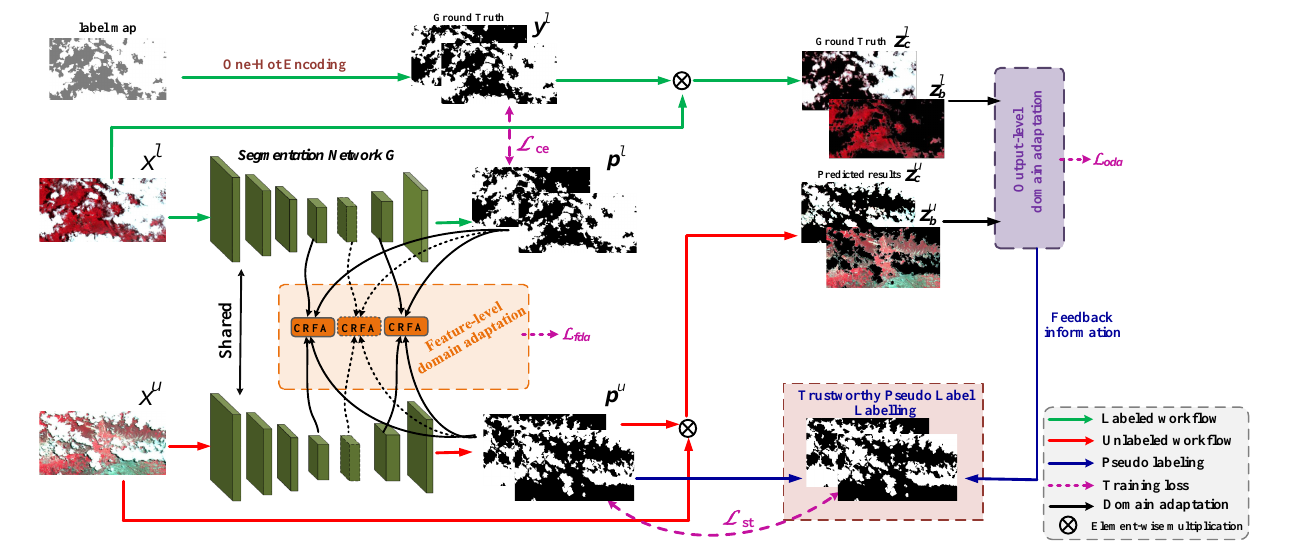
Figure 3. The detailed structure of the proposed